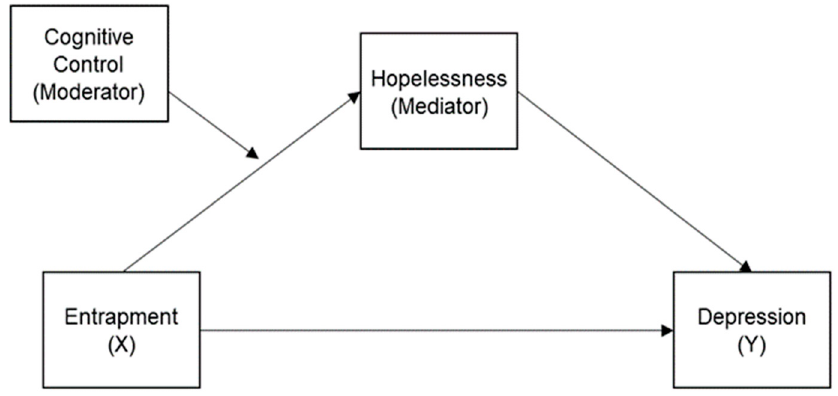
Figure 1. The hypothesized moderated mediation model.